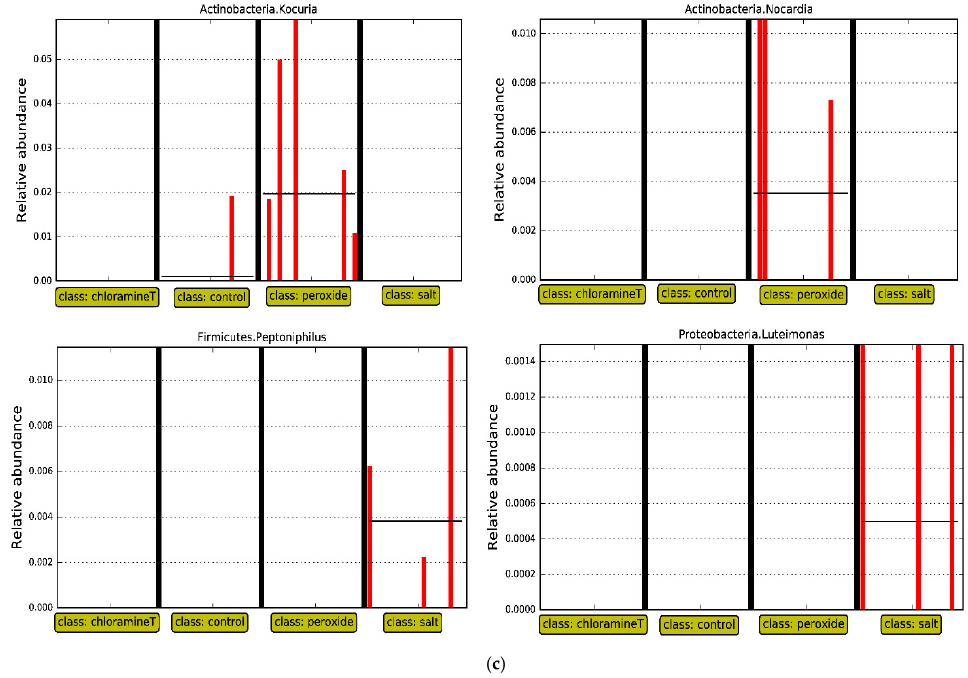
Figure 5. LEfSe analyses for ( a ) fish exposed to control treatment only, comparing hatchery and wild origins; ( b ) fish from all chemotherapeutant treatments against control across fish samples origi- nated from wild; ( c ) fish from all chemotherapeutant treatments against control across fish samples originated from hatchery. We likewise compared communities of fish from the control treatment within each origin (wild and hatchery, respectively) to other chemotherapeutant treatment groups (one vs. all). LEfSe analyses performed with fish from the wild group detected two differ- entially abundant taxa associated with genus Clostridium_XVIII (Phylum Firmicutes ) and Methylocystis (Phylum Proteobacteria ). Both genera were present in high abundance in the guts of fish exposed to the peroxide treatment, and for genus Clostridium_XVIII . The taxa were also abundant in the guts of fish from the salt treatment (LDA score higher than 2.0, p < 0.05, see Figure 5b). For hatchery origin fish, LEfSe analyses on fish that were treated